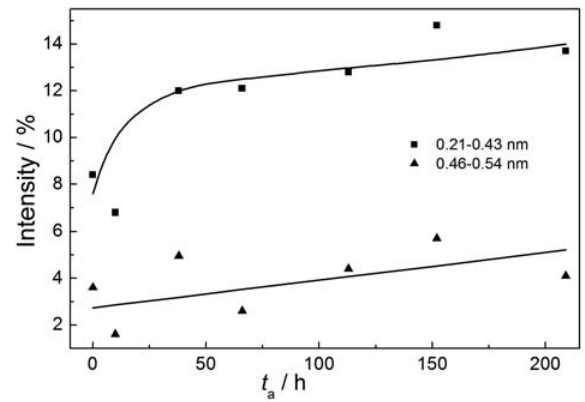
Figure 4. Positron annihilation lifetime spectroscopy (PALS) data of gels aged for 0, 10, 38, 66, 113, 159, and 209 h. Squares repre- sent values calculated from experimental τ values, while triangles 3 represent values calculated from τ , both using Tao-Eldrup model 4 in corresponding ranges of voids sizes. Intensity represents a pro- portional number of the voids in each of the measured samples.